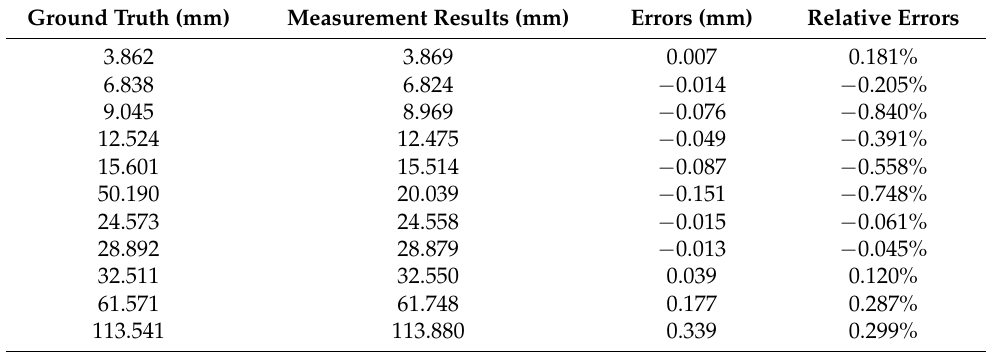
Table 5. Accuracy verification experiment.